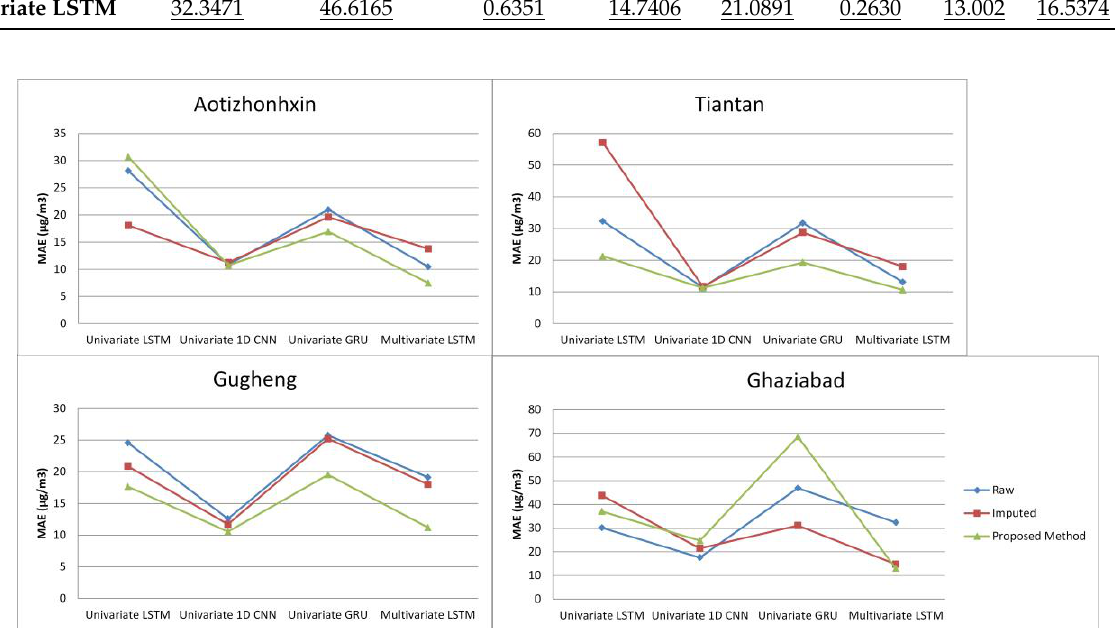
Figure 3. Sample graph of training and validation curve for Tiantan location dataset.